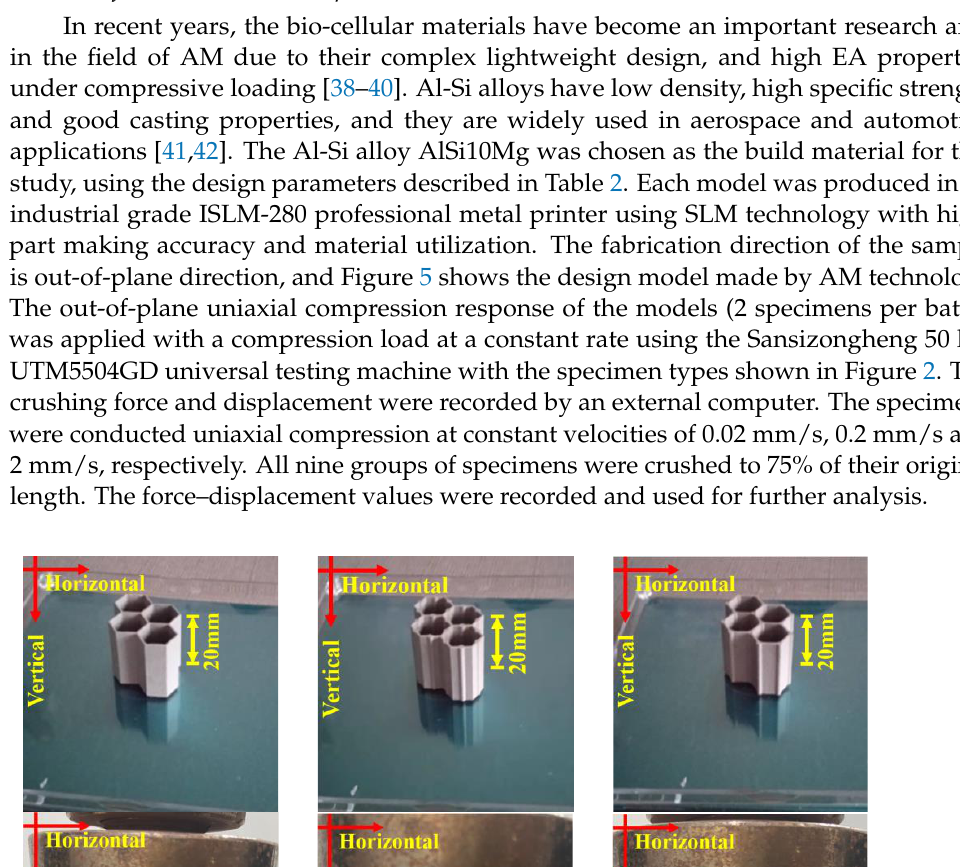
Figure 6. Schematic diagram of the high-speed camera site layout. 2.4. Assessment of the EA Performance In this study, the magnitudes of all crushing parameters were calculated from the force – displacement curves. The PCF [42,43] is defined as the first peak force. The mean crushing force (MCF) [42 – 44] was calculated as the average crushing force in the dis- placement range of 3 to 15 mm. The formula for calculating MCF is: